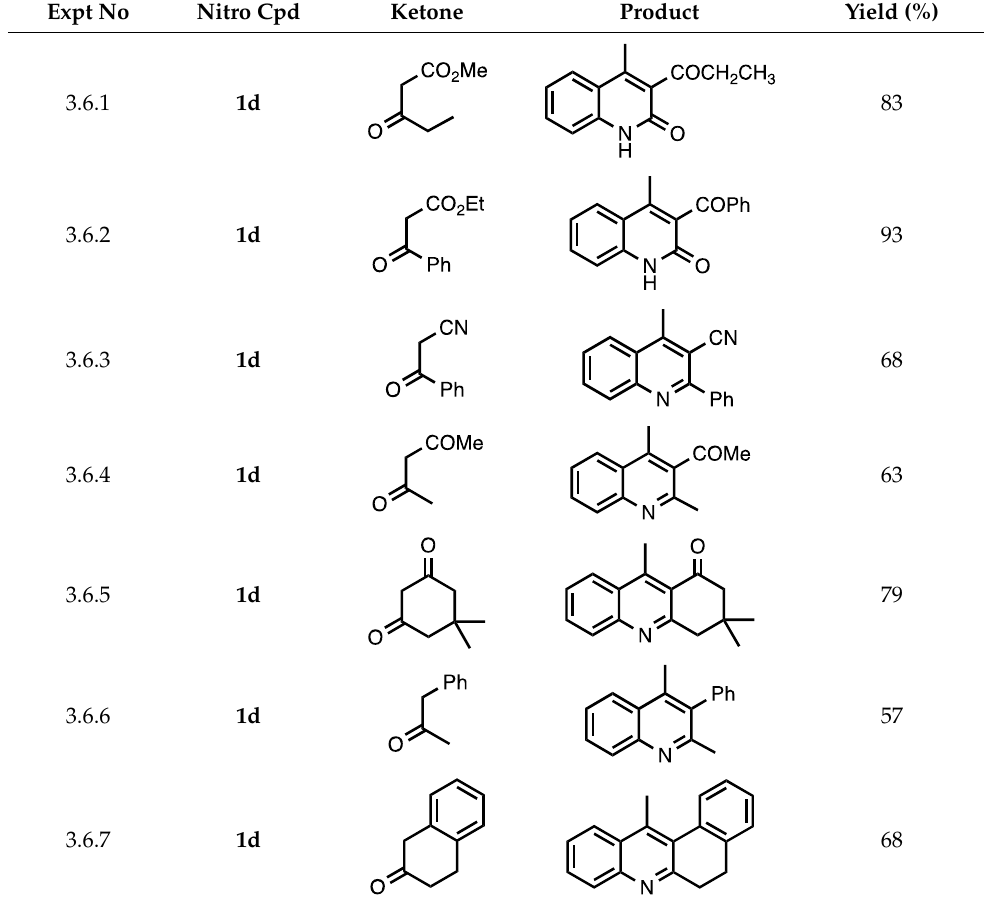
Table 4. Domino nitro reduction-Friedländer reaction using 2-nitroacetophenone ( 1d ).